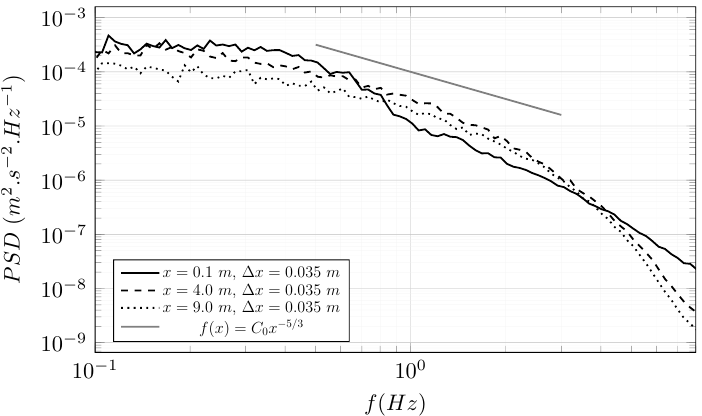
Figure 15. Power spectral density calculated from the stream-wise velocity component computed from a LBM-LES simulation using DFSEM with L = 1.2 m, u (cid:48) 2 x is the distance from the inlet of the LBM